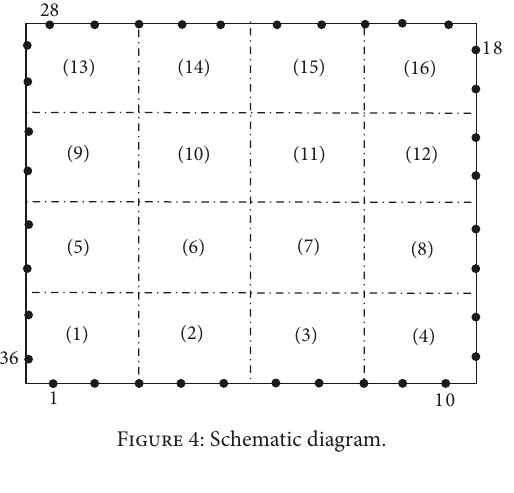
Figure 4: Schematic diagram.